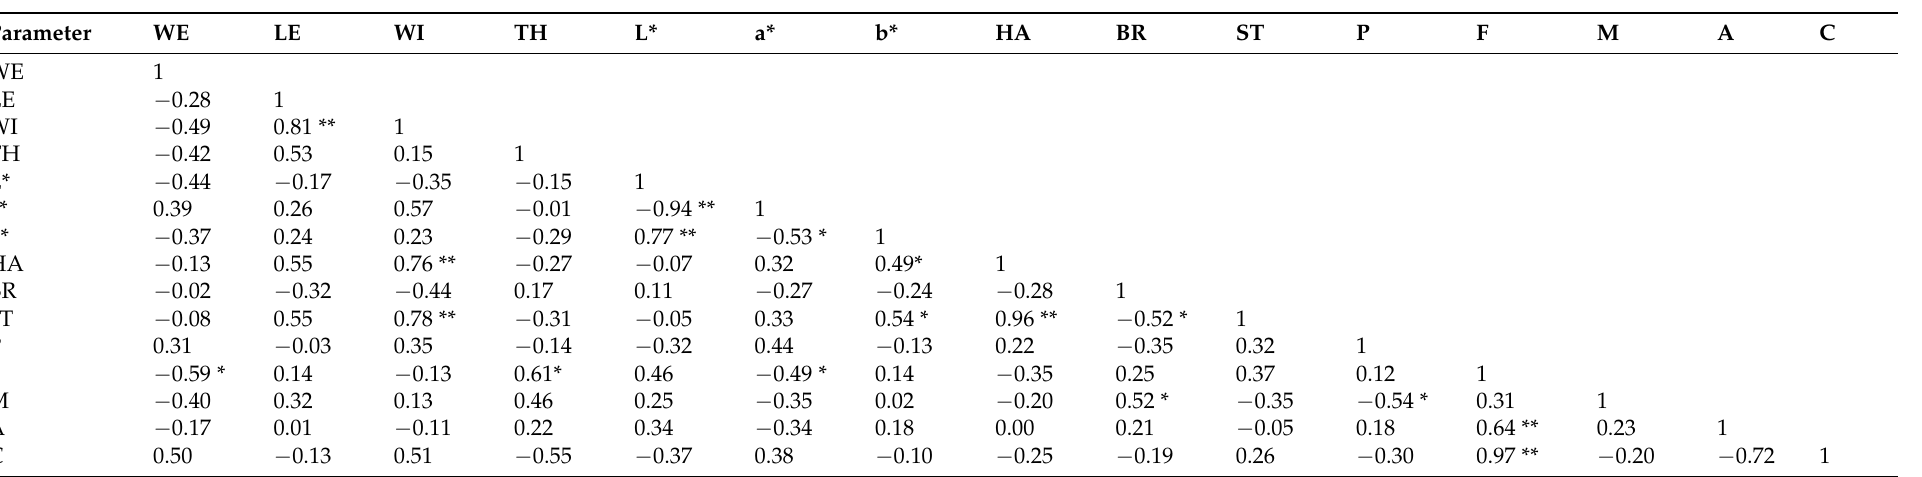
Table 6. Pearson coefficient correlation of physicochemical properties of snack bar